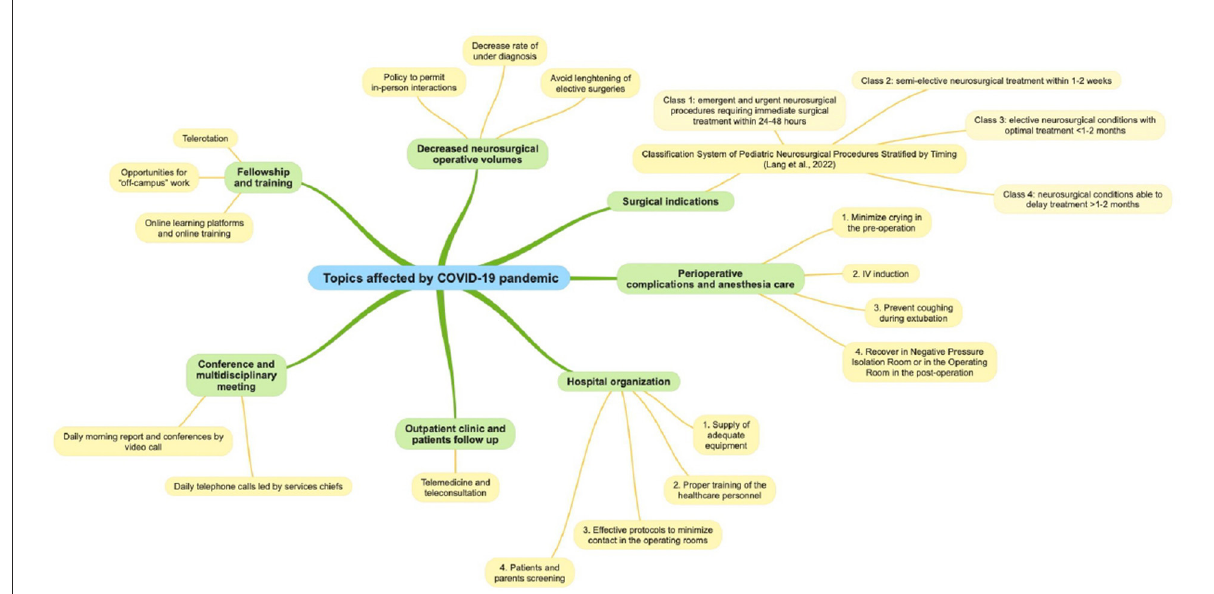
FIGURE1 Summary of the most important topics affected by COVID-19 pandemic and related